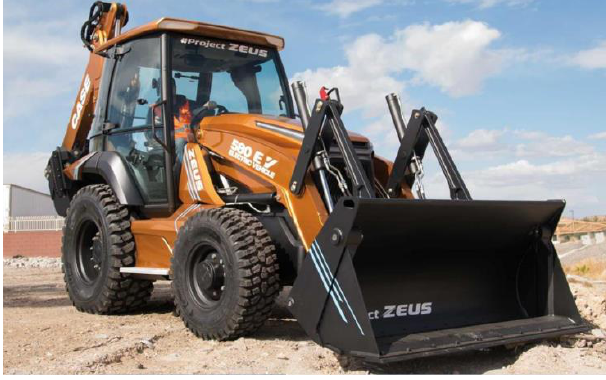
Fig. 31. Case 580 EV „Project Zeus” [43]